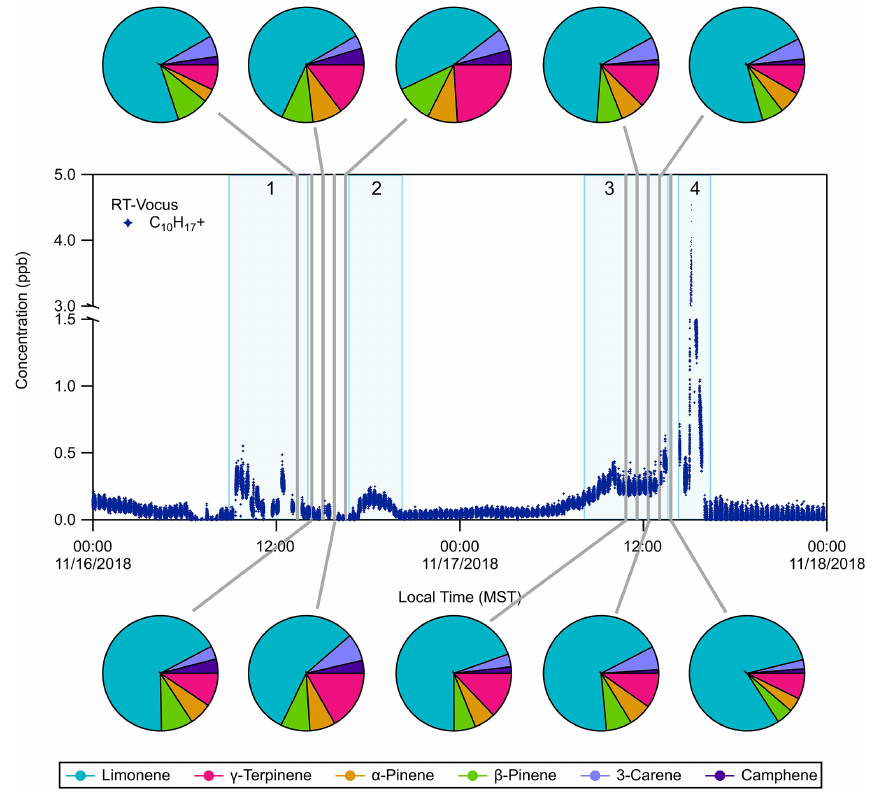
Figure 2. RT-Vocus detection of C 10 H + with occasional speciation with GC-Vocus analysis. The RT-Vocus trace only contains room air 17 measurements for simplicity. Pie charts show the GC-Vocus speciation of the RT-Vocus C 10 H + signal into six resolved monoterpene species 17 during each of the highlighted (grey) sampling periods. The pie chart fractions represent the contribution (in concentration, ppb) of each monoterpene isomer to the total monoterpene concentration measured by GC-Vocus. Some specific events are numbered and highlighted in light blue with the following distinctions: (1) exercise session, (2) in flow of outdoor air, (3) football game, and (4) post-game